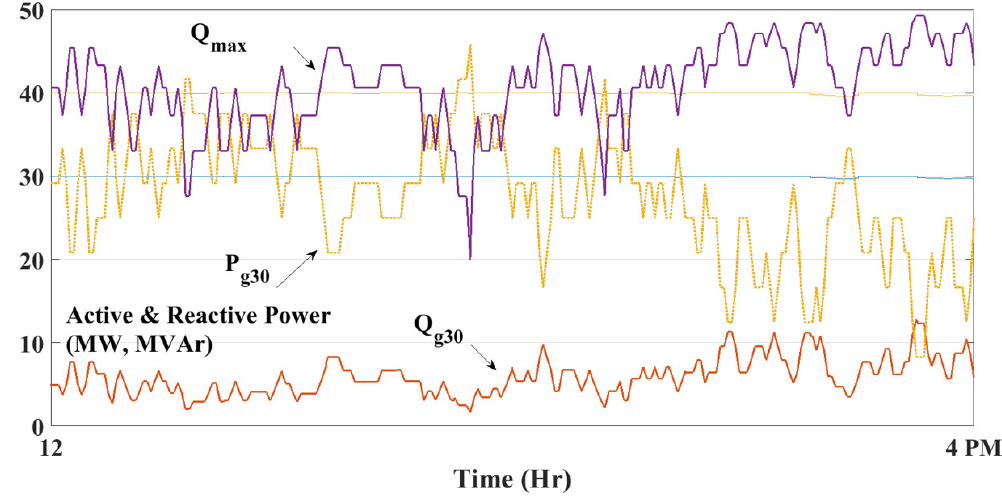
Figure 12. Active and reactive power generation of a 50 MW wind farm located at bus “30” of the IEEE